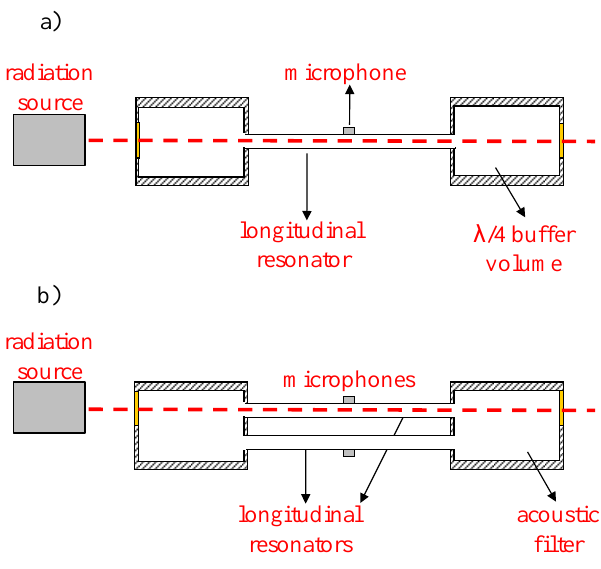
Figure 2. (a) Resonant PA cell with one resonator (typical resonator length of 100–300 mm) and two buffer volumes (half resonator length). (b) Differential PA cell. with two resonator tubes and acoustic